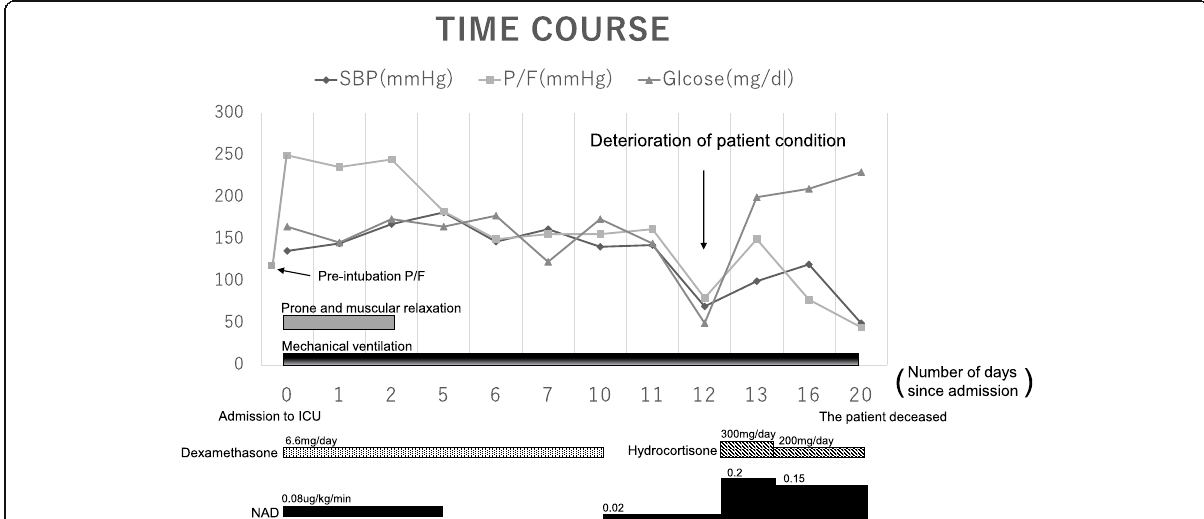
Fig. 1 The clinical course. SBP, systolic blood pressure (mmHg); P/F, the ratio of arterial oxygen partial pressure to fractional inspired oxygen (mmHg); Glucose, blood sugar (mg/dl); NAD, noradrenaline ( μ g/kg/min). The units of the vertical axis mean mmHg for SBP and P/F, or md/dl for glucose. The unit of the horizontal axis means the number of days since ICU admission. The stepped graphs show the doses of continuous infusion of NAD and steroids. Belt-lines show the periods of mechanical ventilation and prone positioning combined with muscle relaxation. His pre-intubation P/F ratio was approximately 110 mmHg